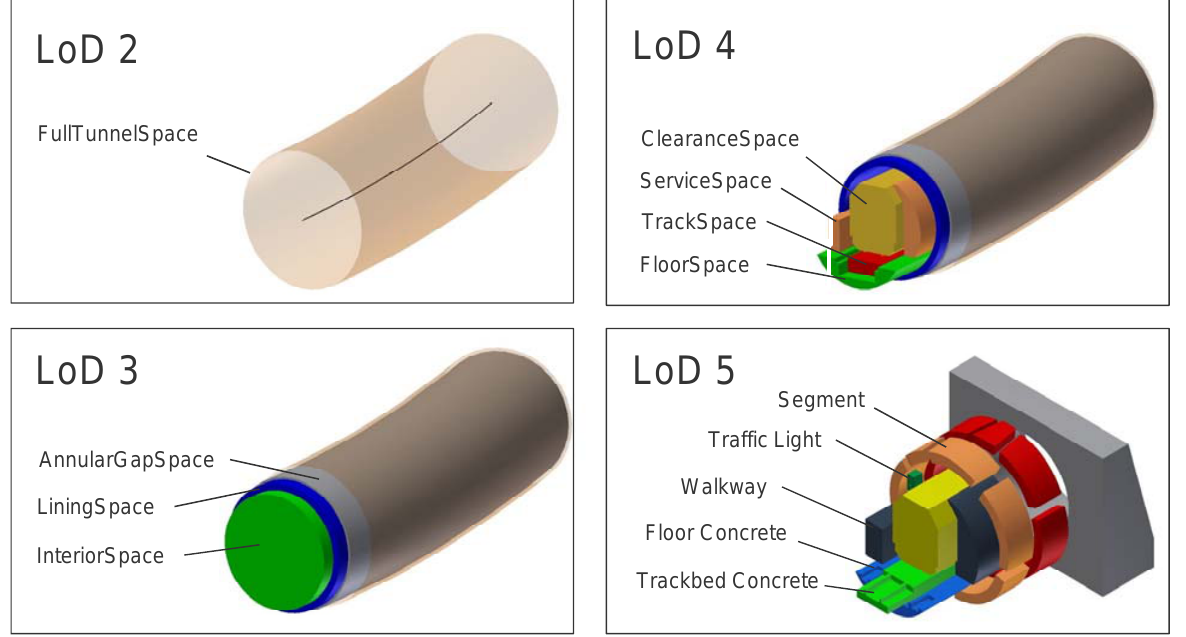
Figure 7. A 3D representation of the different LoDs of the multi-scale shield tunnel product